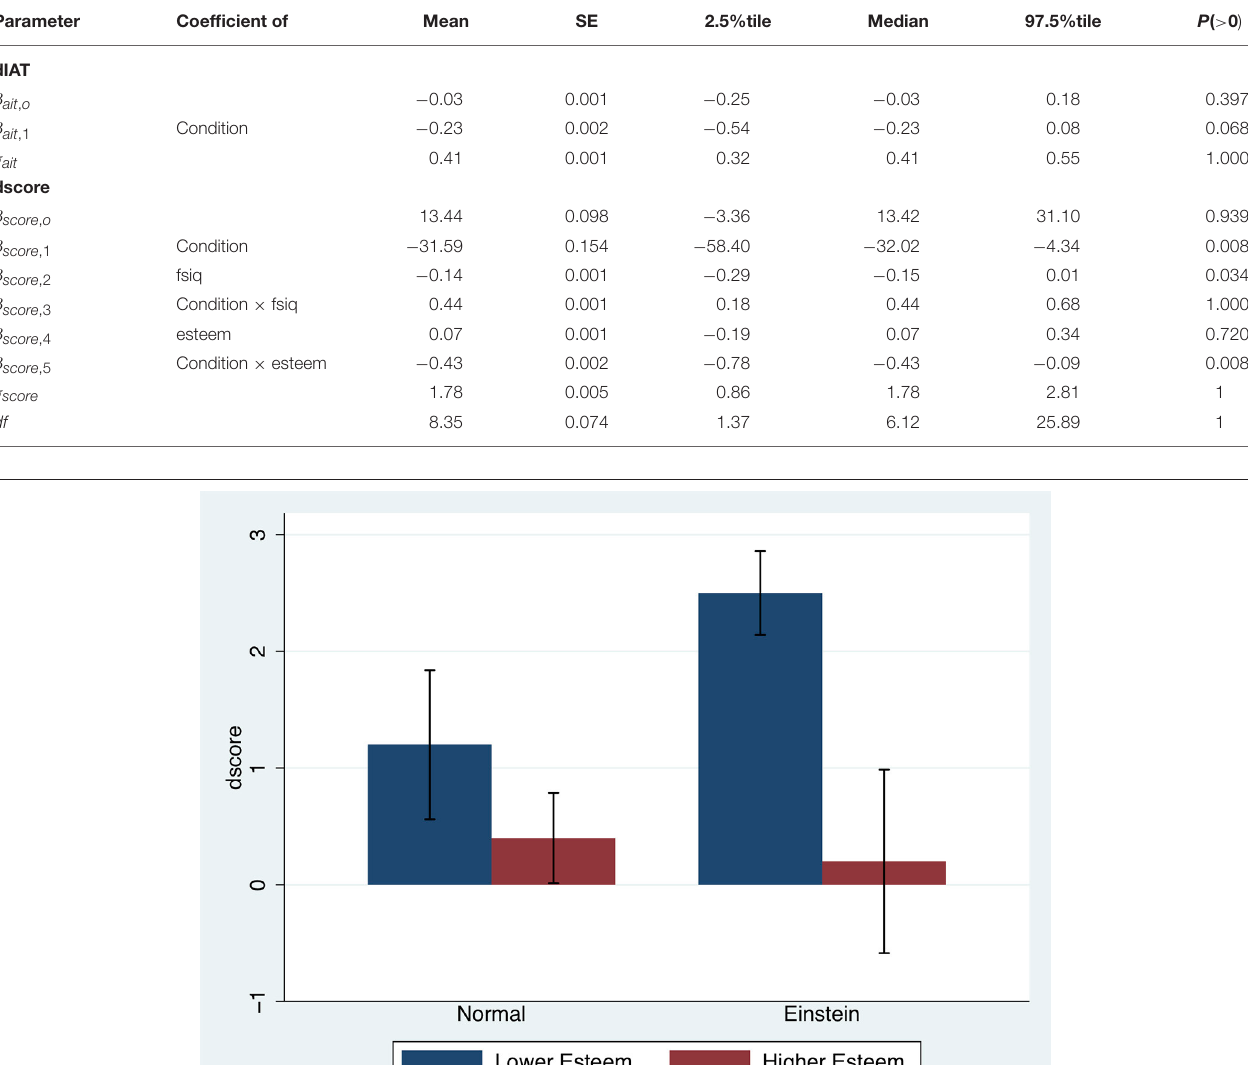
TABLE 3 | Posterior distributions of the parameters of the model (EQN 1). Parameter